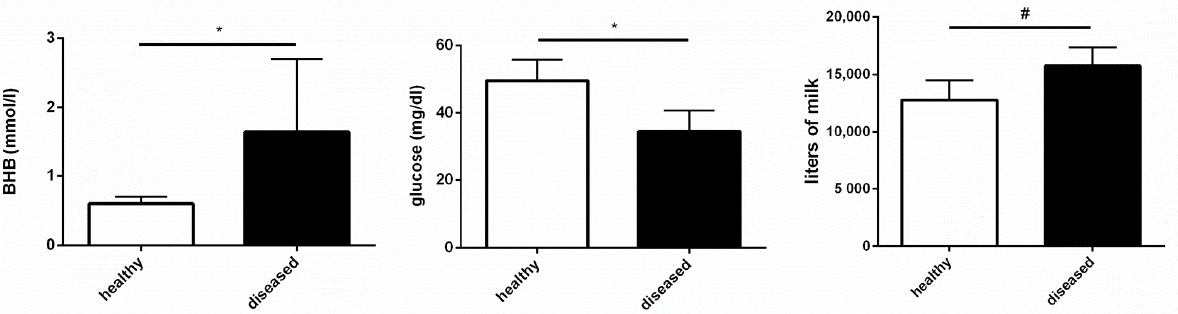
Figure 3. Metabolic and production parameters in healthy and diseased cows. Plasma BHBA and glucose were quantified at 5 DIM (days in milk). Effective milk production was calculated at the end of lactation of each animal. Values are medians, Q1 and Q3. # p < 0.1, * p < 0.05.